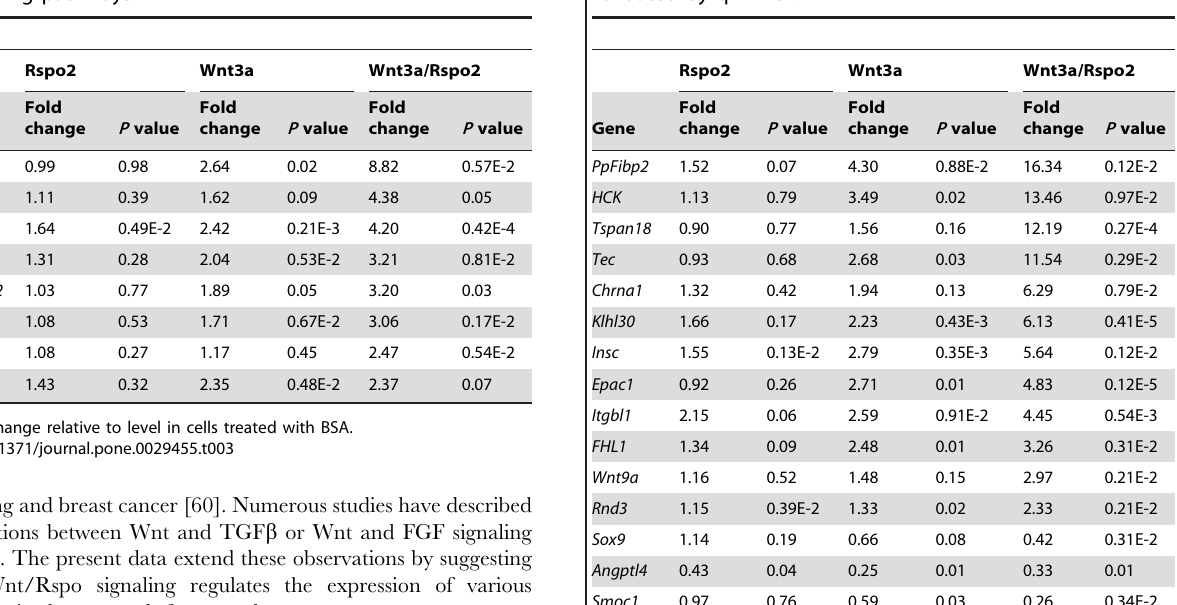
Table 3. Microarray data of genes in other growth factor signaling pathways.